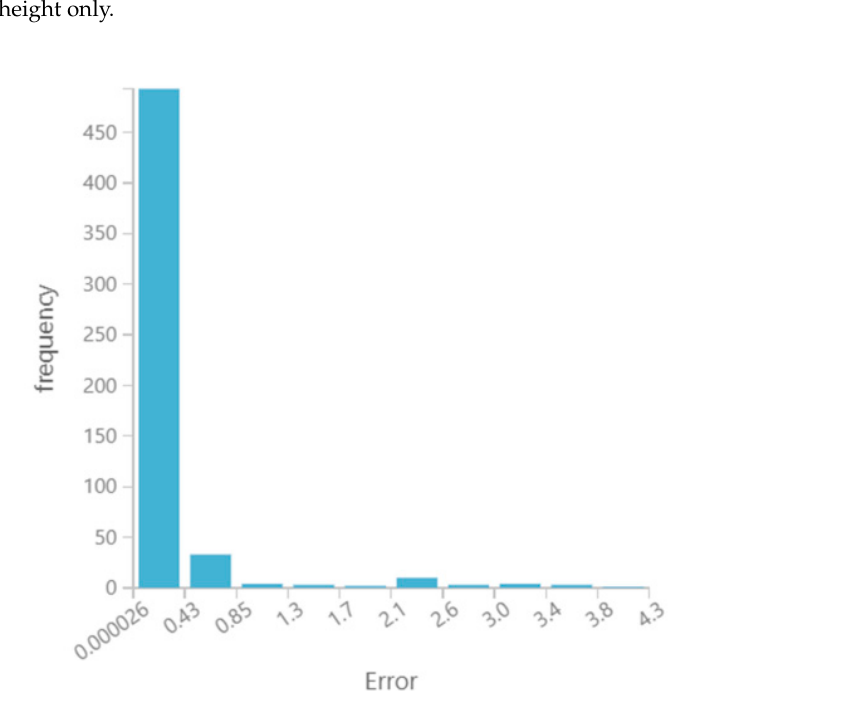
Figure 9. Error histogram of the predicted values of the dc / dt for the industrial dataset with the two operating parameters of total oxygen flow and lance height only.